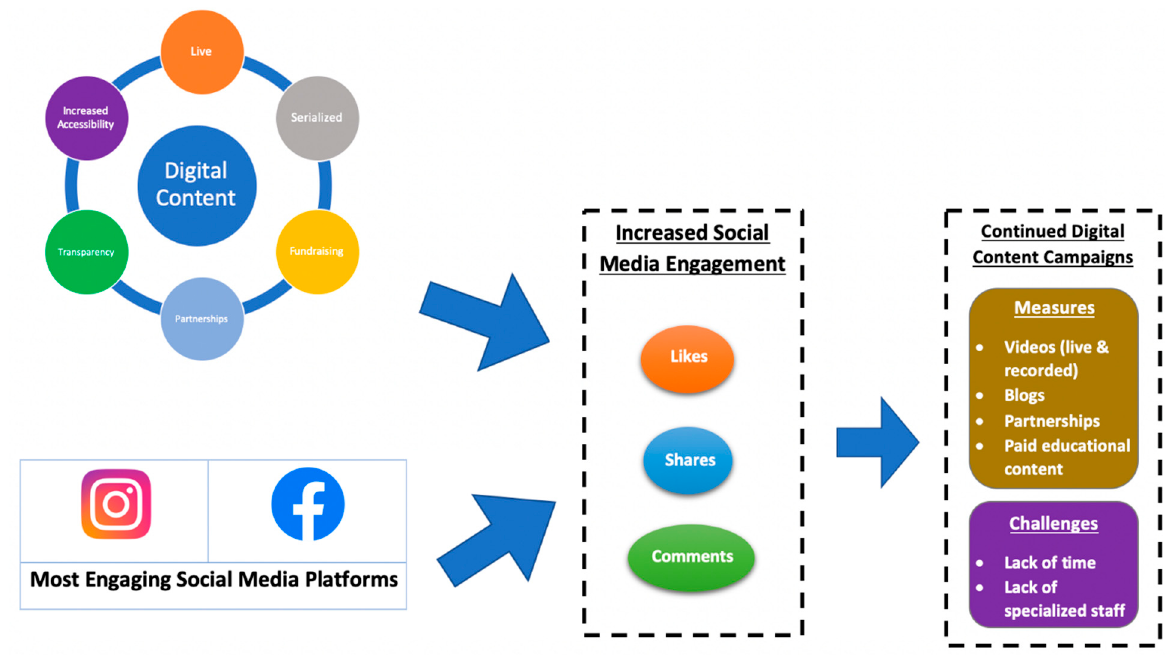
Figure 1. Factors influencing continued digital content campaigns after COVID-19 temporary